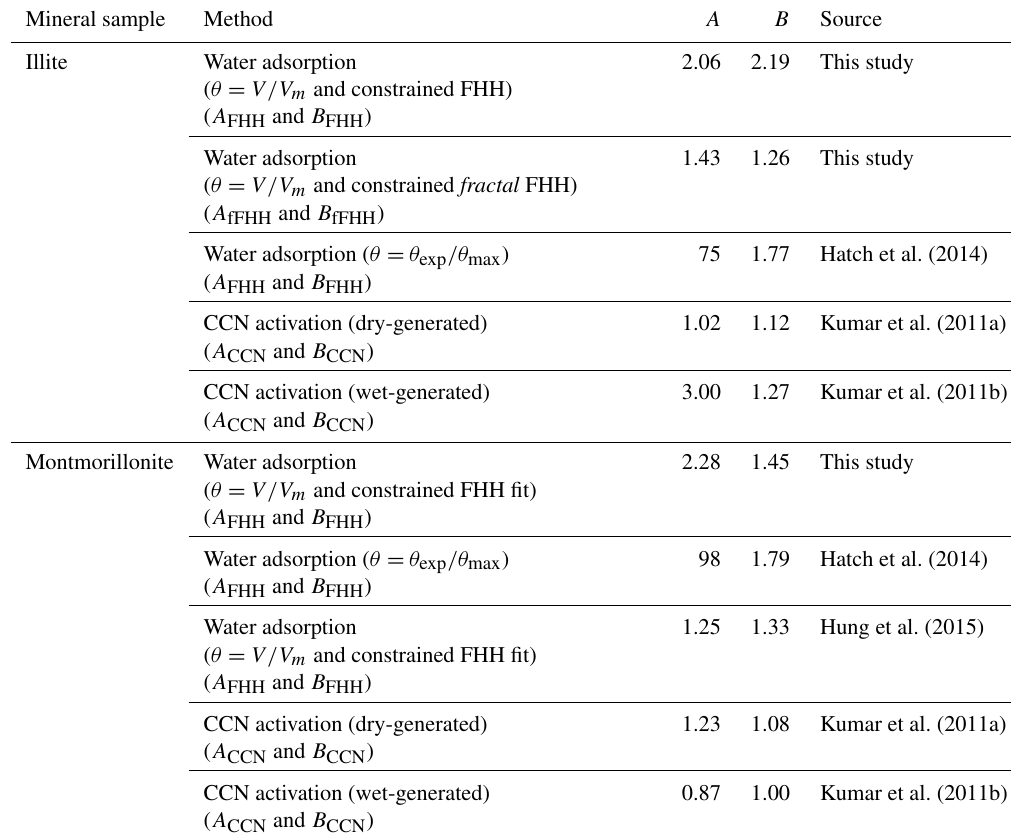
Table 1. A FHH and B FHH determined from water adsorption and CCN activation measurements of dry- and wet-generated illite and mont- morillonite clays. Mineral